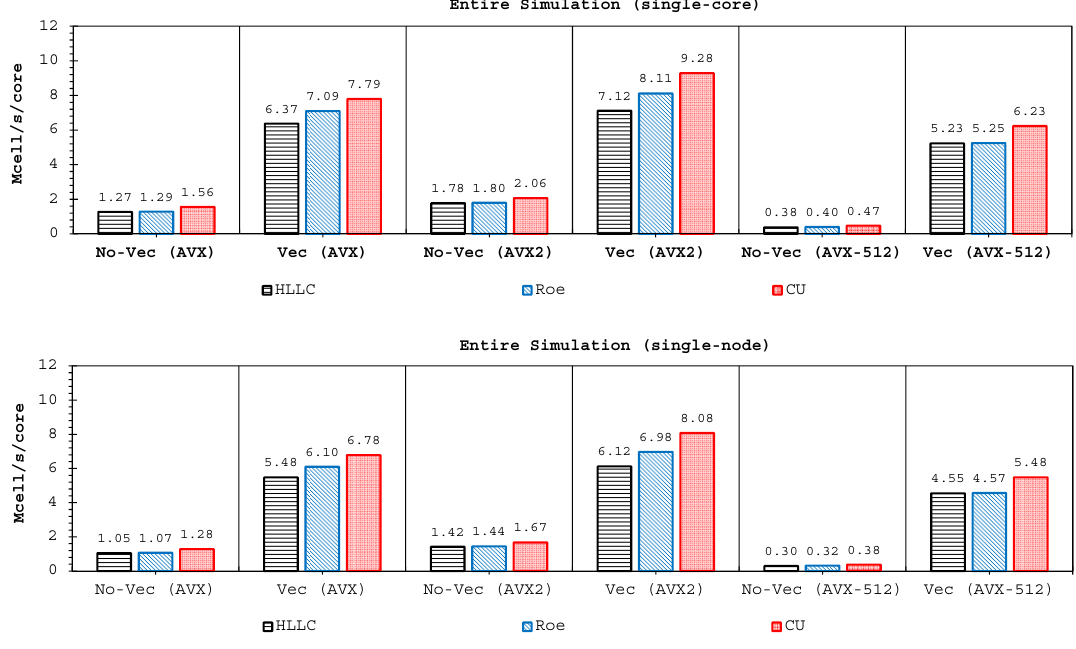
Figure 21. Comparison of performance metrics for the entire simulation.